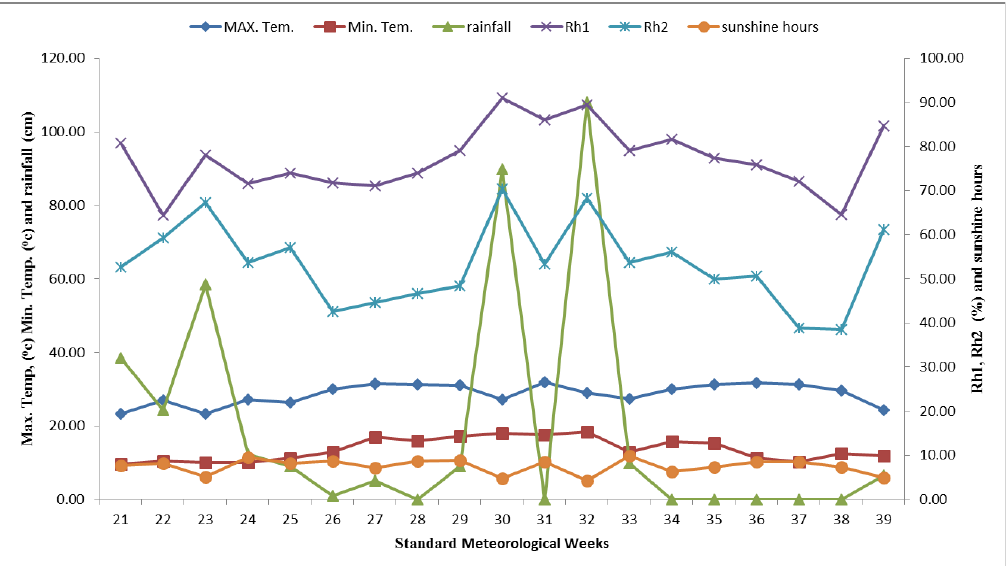
Figure 1. Mean meteorological data during maize crop growth season of 2019. Where, SSH means Sunshine hours, and RH 1 and RH 2 means maximum and minimum relative humidity.